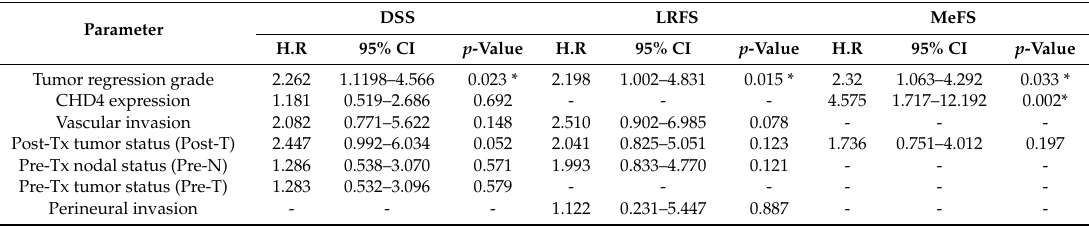
high levels of CHD4. Knockdown of CHD4 in radio-resistant HCT-116-R cells led to enhanced cytotoxicity upon IR exposure, as compared to that in radio-resistant HCT-116-R (Figure 4C). Notably, the over-expression of CHD4 in SW48 cells led to pronounced radio-resistant phenotype, compared to parental SW48 cells (Figure 4D). We further validated the role of CHD4 in the radio-resistance of MSS cell line models (HT-29 and Caco-2). As shown in Figure 4E, the depletion of CHD4 in both HT-29 and Caco-2 cells increased their sensitivity to IR. Altogether, these results indicate that CHD4 regulates the resistance of CRC cells to